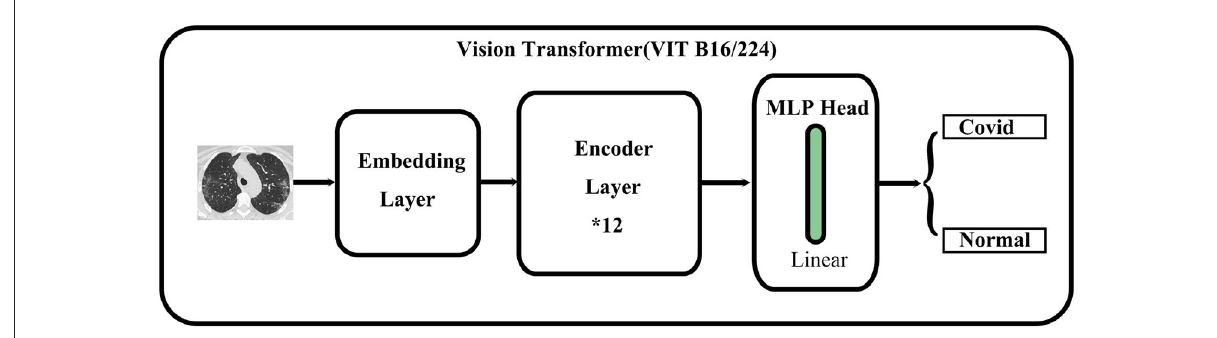
FIGURE1 Concise structure of Vision Transformer.